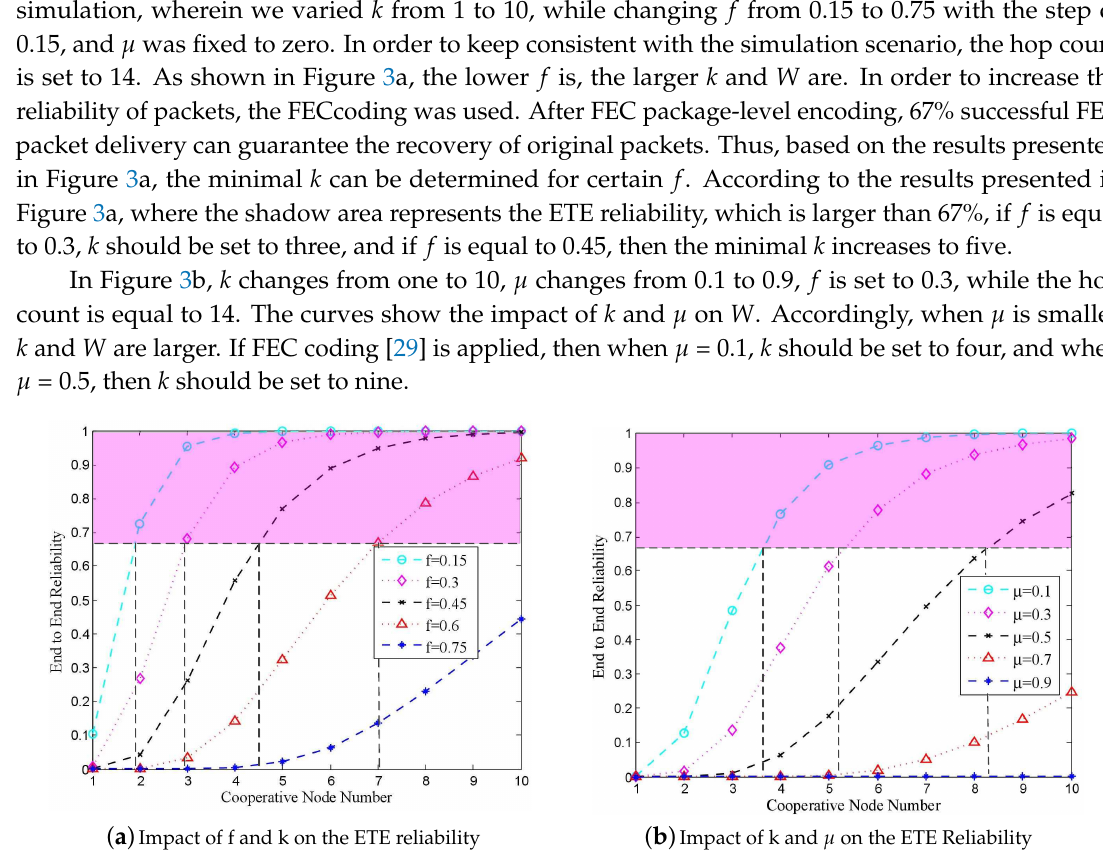
Figure 3. The impact of f , k and µ on reliability.